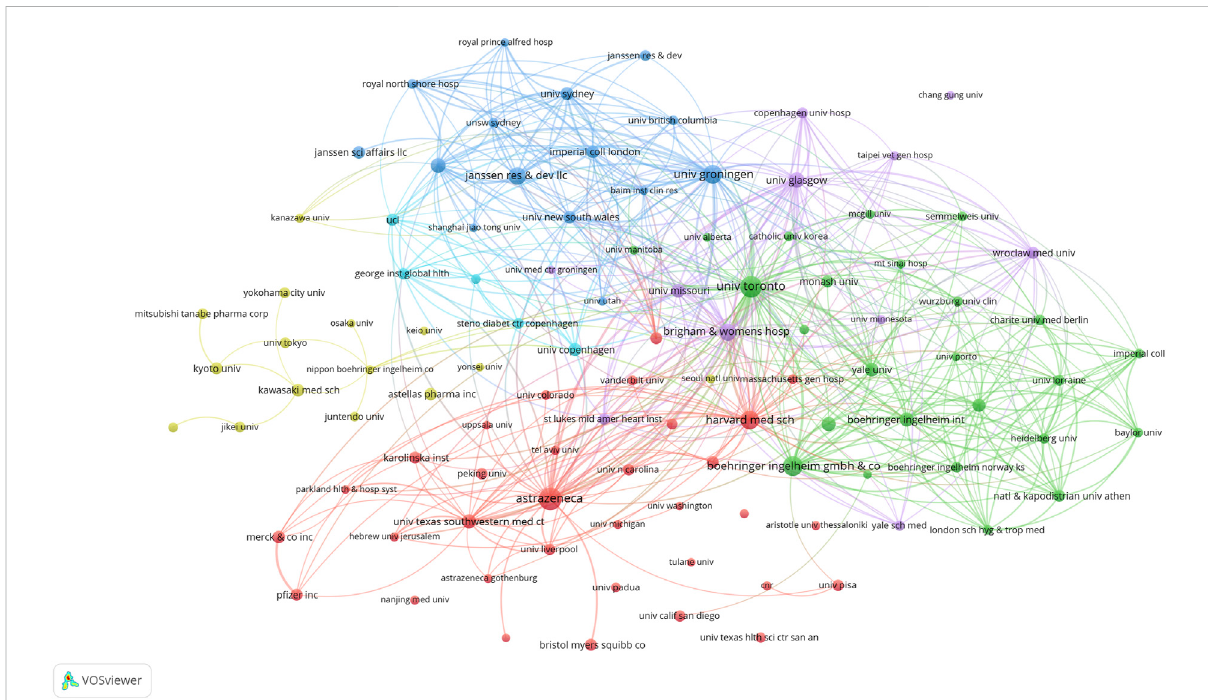
FIGURE 4 VOSviewer network visualization map of institutions involved in SGLT2 inhibitor research. Collaboration analysis of the top 105 of 5,518 institutions. Node size represents the co-authorship frequency, and the line between two nodes represents a collaboration between the two countries, regions, or institutions; the thicker the line, the closer the collaboration.